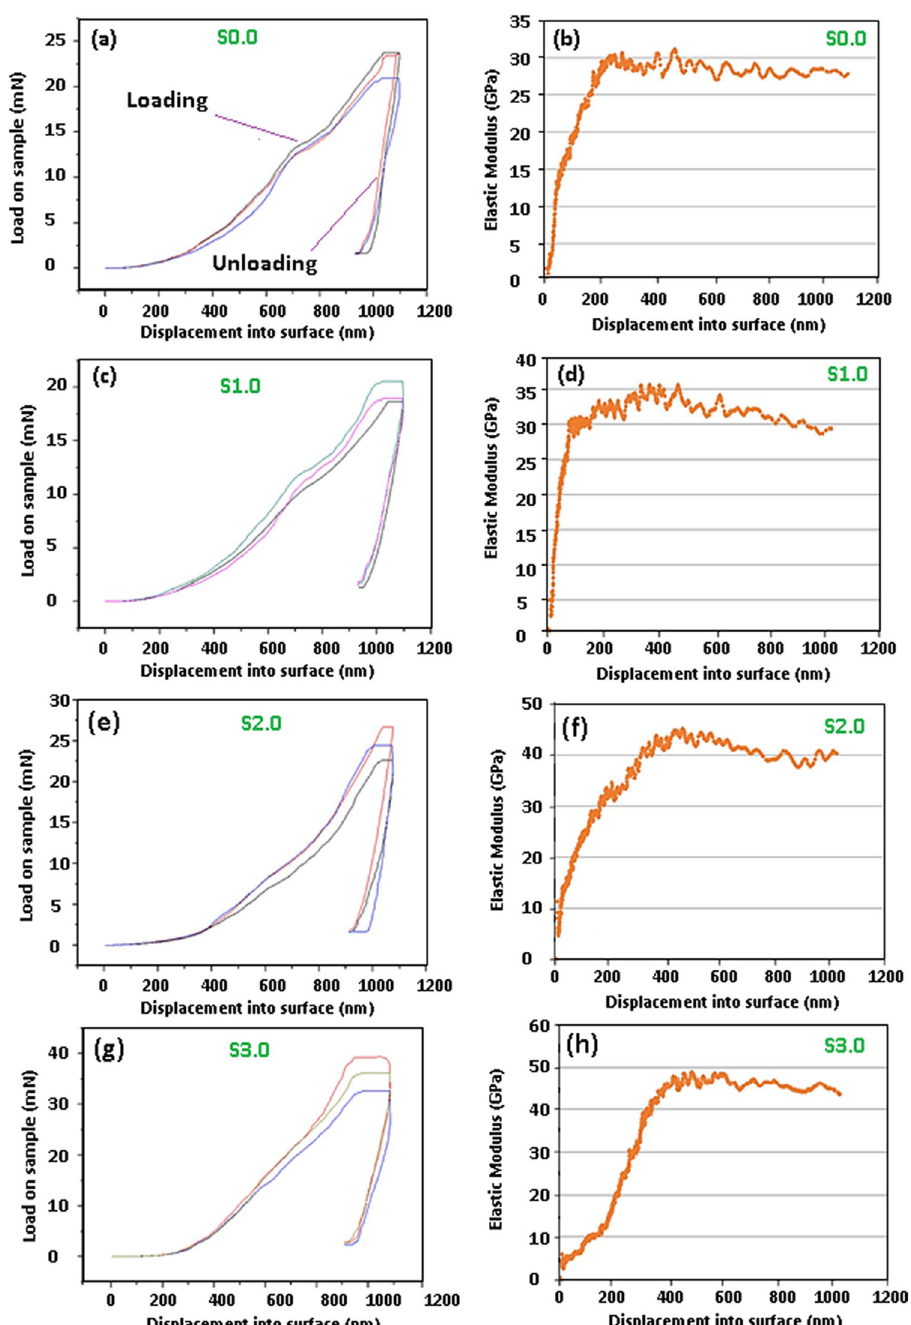
Figure 9. Characteristic load vs nanoindentation depth for samples S0, S1.0, S2.0, and